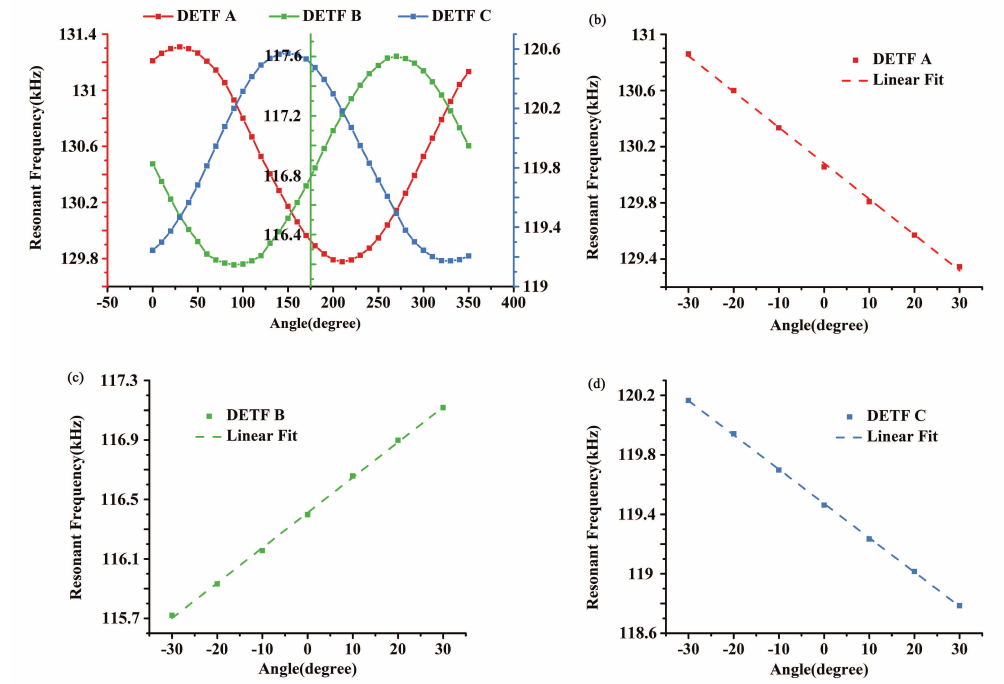
Figure 8. ( a ) Resonant frequency of the three DETFs got by downward sweeps; ( b ) Frequency of DETF A in sensitive region; ( c ) Frequency of DETF B in sensitive region; ( d ) Frequency of DETF C in sensitive